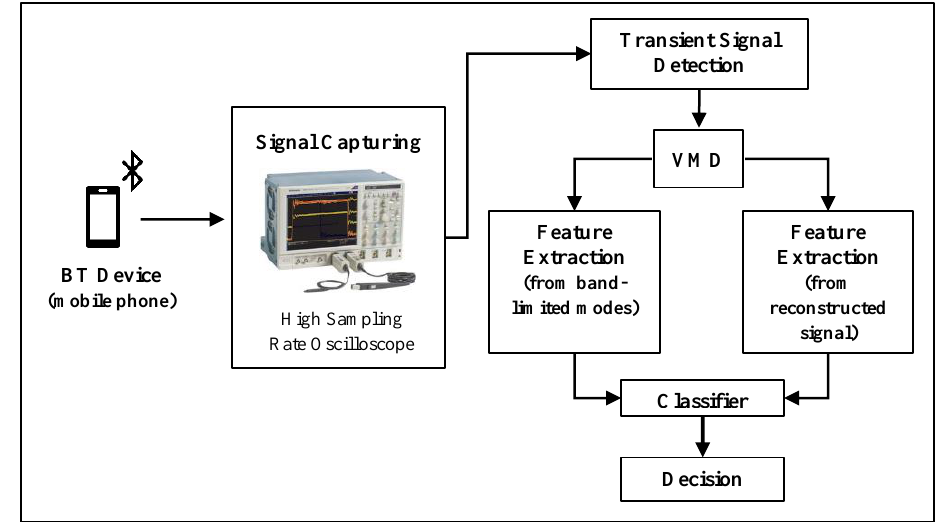
Figure 1. Operational diagram of the RFF implementation.